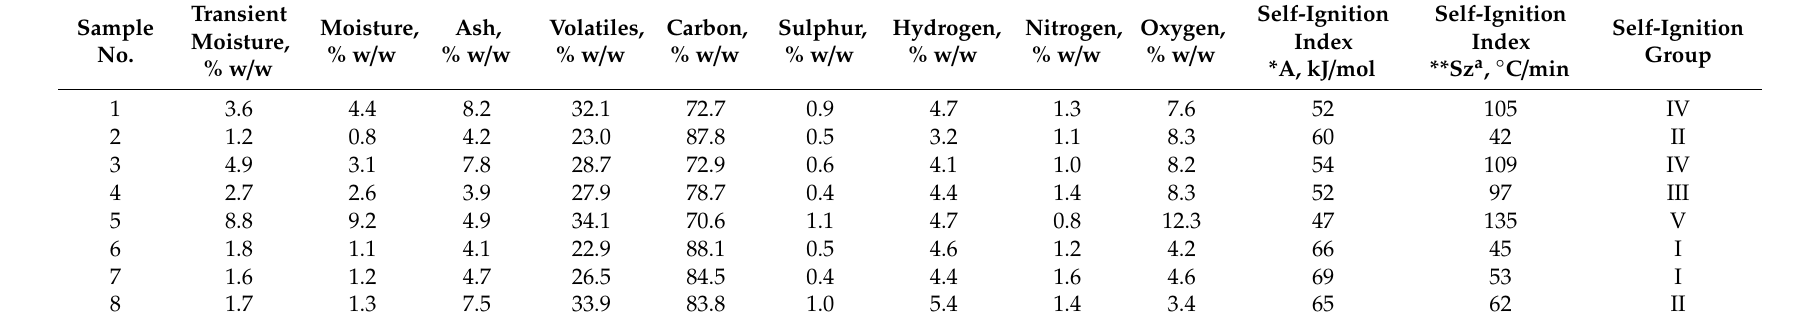
Table 1. Physical and chemical parameters of coal